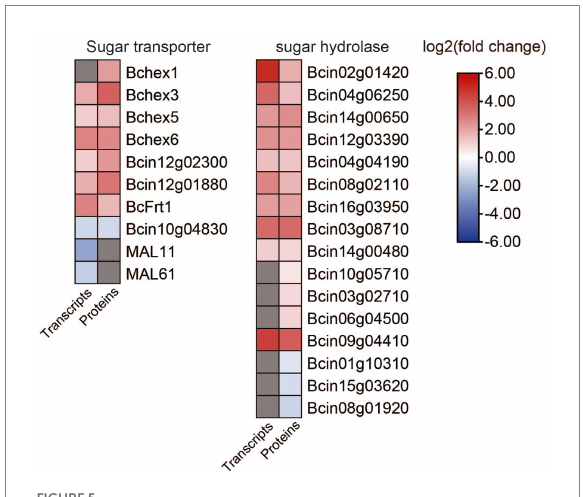
FIGURE 5 Heat map of DEGs and DEPs in sugar transport and degradation between the B. cinerea TB-31 and Δ Bcfrp1. The heat map was generated with the software TBtools (Toolbox for Biologists) V1.0971. The gray color means no significant difference at the transcription or translation